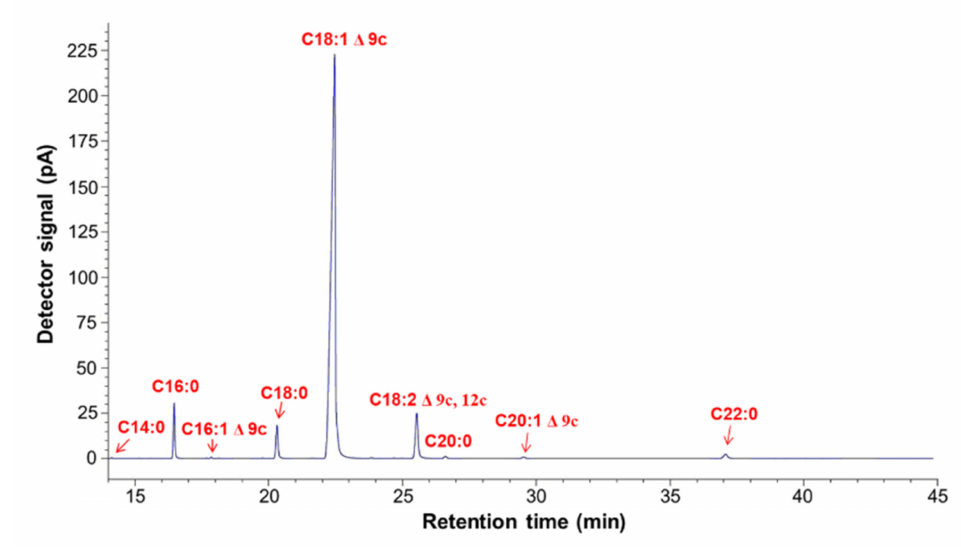
Figure 1. GC-FID chromatogram of